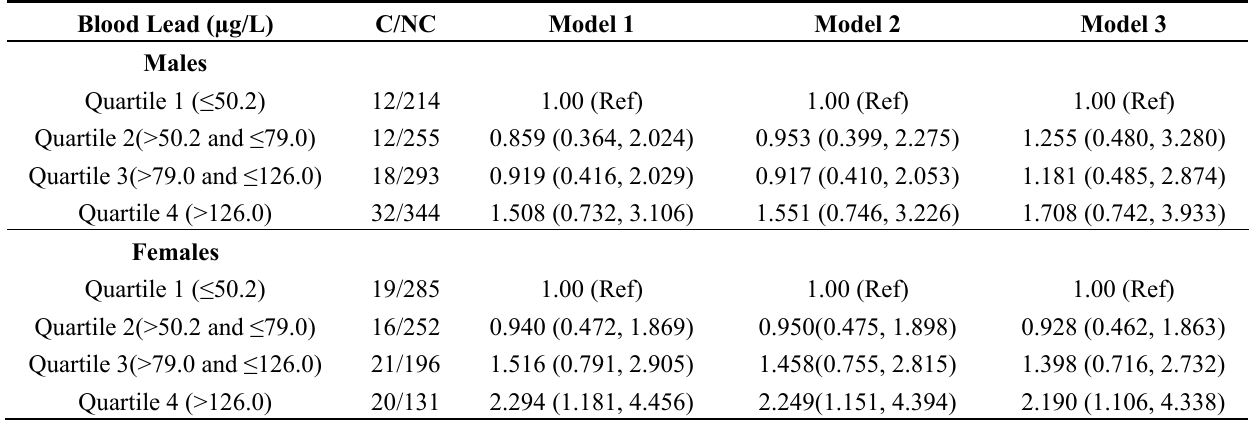
Figure 1. Unadjusted prevalences of hyperuricemia by blood lead quartiles for males and females. a p values determined by chi-square tests across the four quartiles. Table 4. Odds ratios (with 95% confidence intervals) for hyperuricemia by blood lead concentration. Blood Lead (µg/L) C/NC Model 1 Model 2 Model